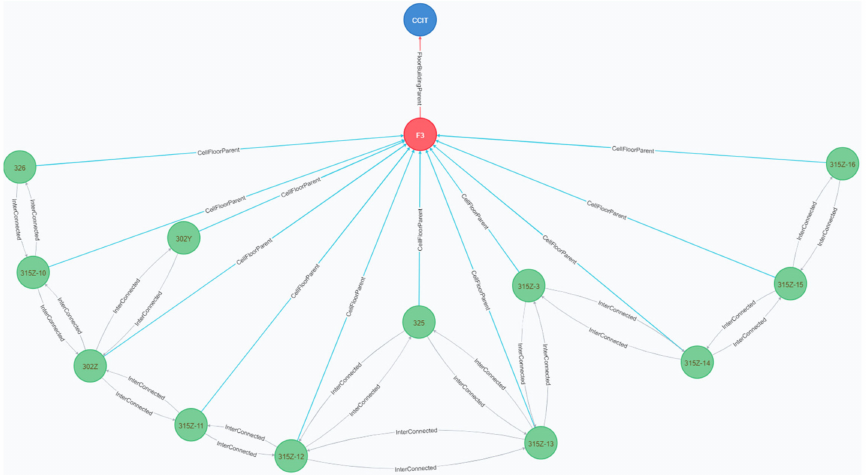
Figure 12. Hierarchical spatial graph-based representation of the 20 selected building including OGC IndoorGML cells (green circles), floor (red circle), building (blue circle), inter-layer topological connections among IndoorGML cells (gray arrows), intra-layer topological connections among IndoorGML cells and their corresponding floor (light blue arrows), and intra-layer topological connections floor and corresponding building (red